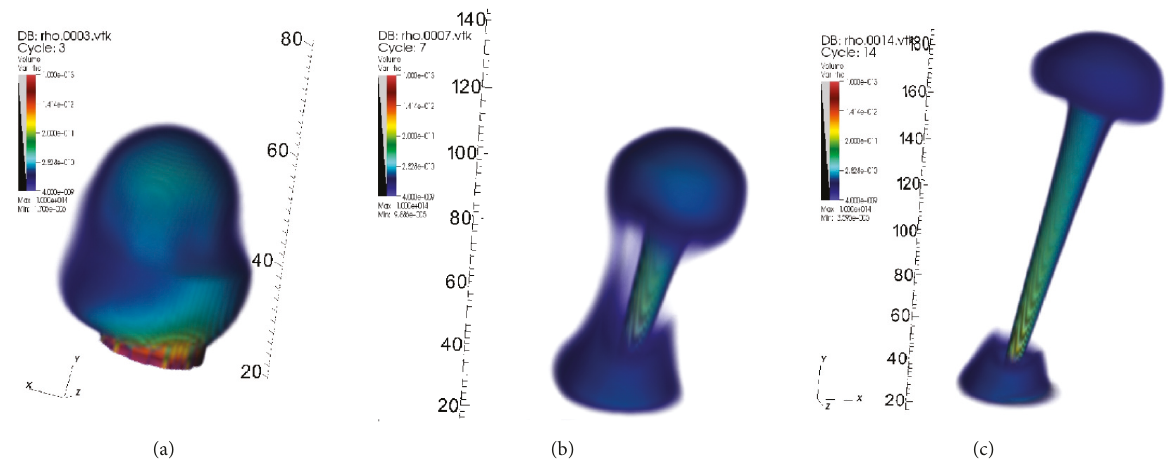
Figure 5: Scenario D: a series of snapshots depicting the density evolution (logarithmic plots) for the run4. Here we can see 3D plots of the jet proton density in space, at specific time instants of the simulation run. This time the jet is quite much heavier than both surrounding winds, leading to a decreased jet crossing time of the model space. The jet mass flow rate now rests closer to the estimates for SS433. The jet breaks through the accretion disk wind construct and soon crosses the stellar wind at a rapid pace (run4 parameters in Table 1, snapshot intervals of 50/count).